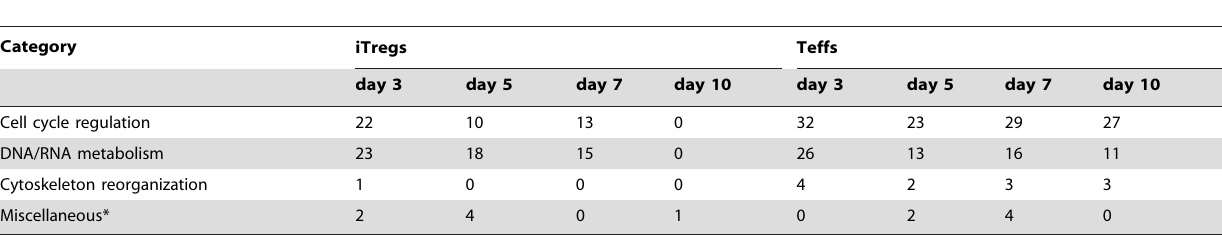
Table 1. Number of significantly over-represented biological processes within different functional categories.